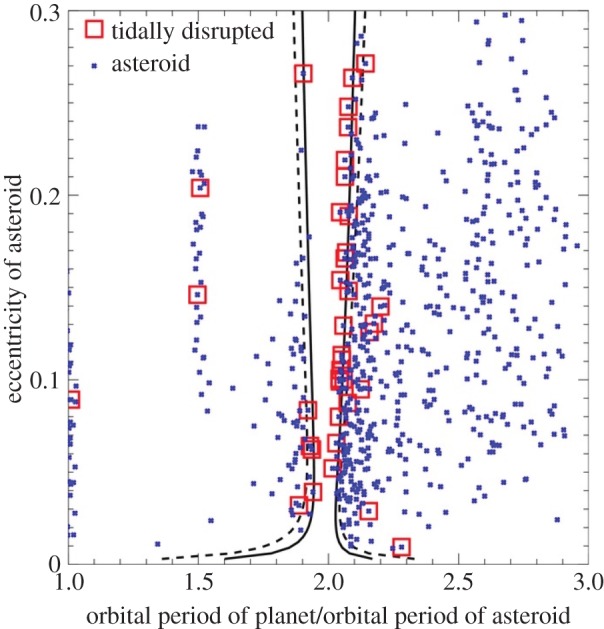
Cosmetically enhanced version of fig. 2 of [59]. How the GB-induced expansion of the libration width of the 2 : 1 mean motion resonance between a planet and asteroids induces the latter to be scattered towards and inside of the WD disruption radius. The solid and dashed lines are the libration widths for, respectively, M⋆(MS)=1.0 M⊙ and M⋆(WD)=0.5 M⊙. Note that a couple asteroids near the 3 : 2 mean motion commensurability are also scattered towards the WD and disrupted.